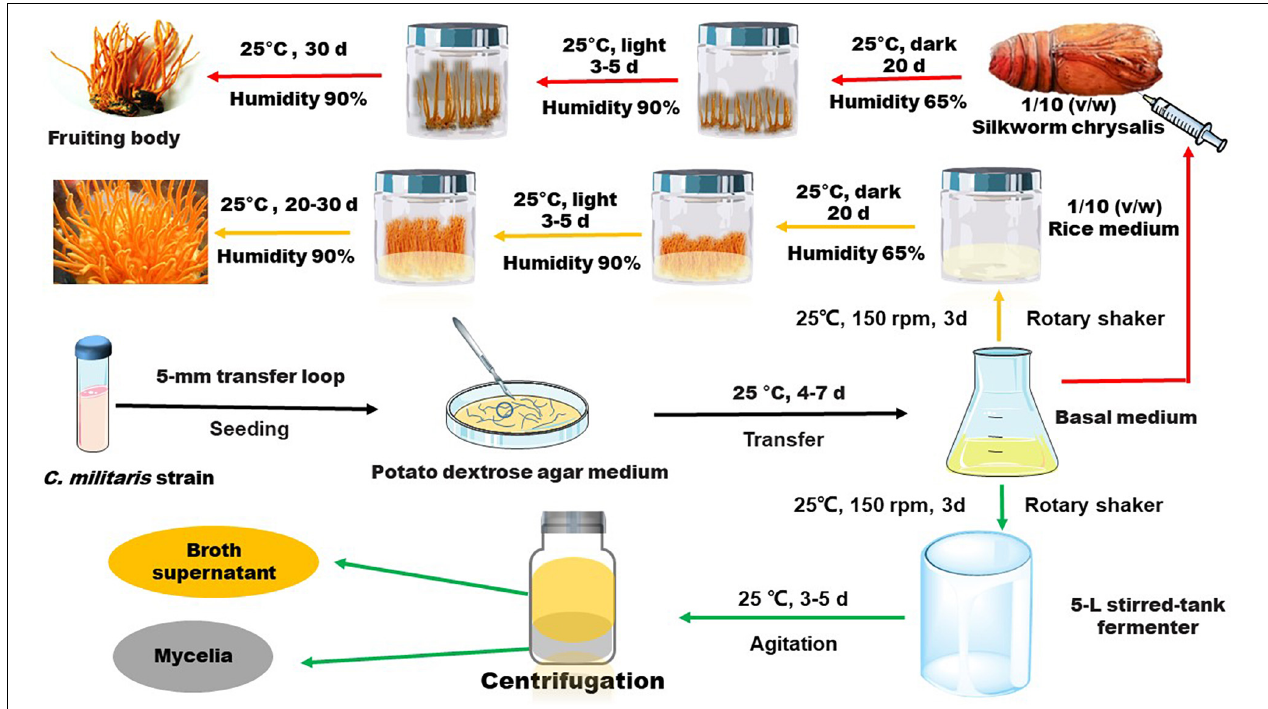
FIGURE 3 | General methods used for fermentation and cultivation of C. militaris . The strain is first cultivated in dishes or test tubes with potato dextrose agar medium, and then it is transferred to liquid medium for a further cultivation. Several days later, the obtained liquid medium is used for an amplified fermentation to obtain mycelia and supernatant through centrifugation. Alternatively, the strain in liquid medium is seeded into solid media (such as rice medium) or be injected into silkworm chrysalis for further incubation to obtain C. militaris fruiting